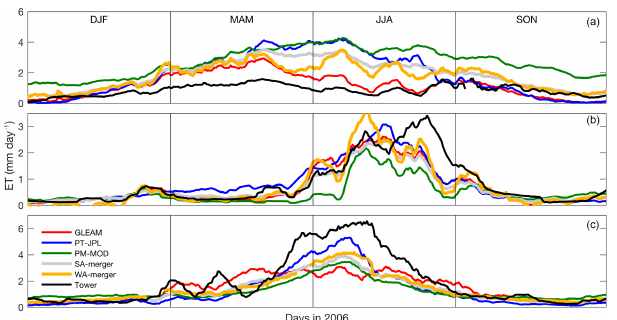
Figure 6. The 2006 time series of the different ET products and the sites shown in Fig. 5: FR-Pue (a) , US-SRM (b) , and US-Ne1 (c) . The daily values are time smoothed using a 10-day moving av- eraged window to better display the more persistent temporal fea-